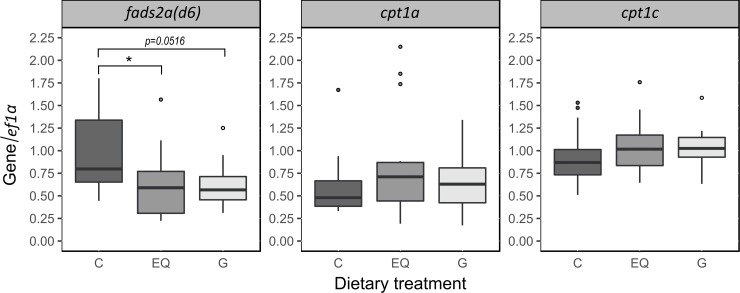
Hepatic mRNA steady state levels.Rainbow trout were fed the experimental diets C, EQ and G for 52 days. Presented are boxplots of relative liver mRNA levels of fatty acyl desaturase 2a (delta-6) (fads2a(d6)) and carnitine palmitoyl transferase 1 (cpt1) a and c, respectively. Hepatic mRNA steady state levels were determined by qRT-PCR analysis and normalized to the housekeeping gene ef1α. Boxes represent values between the 25th and the 75th percentile; whiskers indicate 1.5 SD; medians are indicated by solid lines; outliers (above/below 1.5 SD) are indicated by solid circles. At the end of the experiment, 15 individuals per treatment were sampled in total (n = 15). Statistically significant differences between dietary treatments are represented by asterisks; p < 0.05 (*) based on the statistical models described in Materials and Methods.